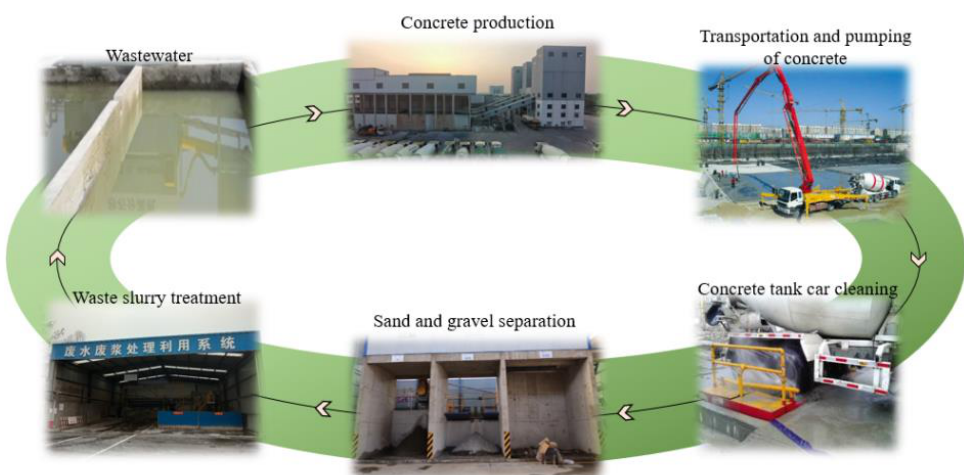
Figure 2. Recycling of wastewater from ready-mixed concrete plant.